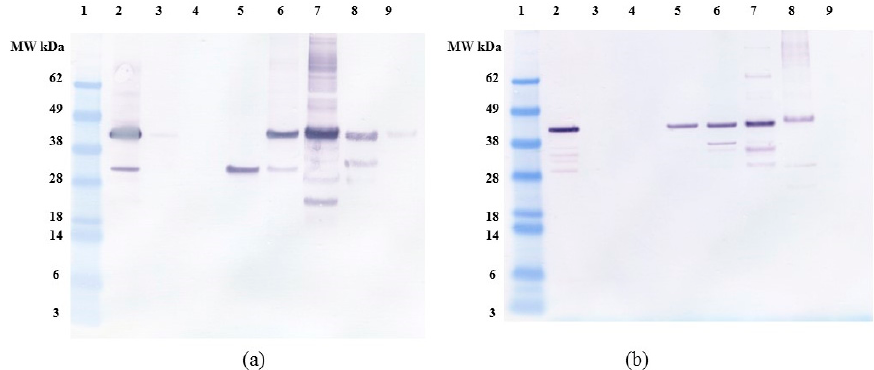
Figure 9. Anti-FLAG western blot of ( a ) C. reinhardtii ( b ) E. coli OPN binding and elution profile from